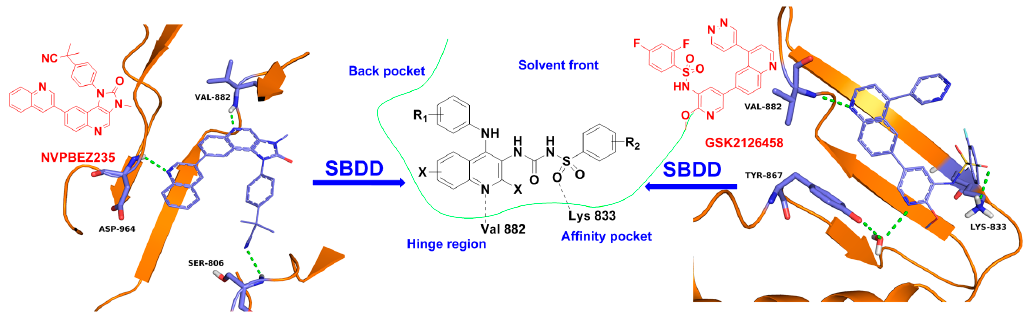
Figure 2. Structure based drug design strategy based on the molecular simulation.